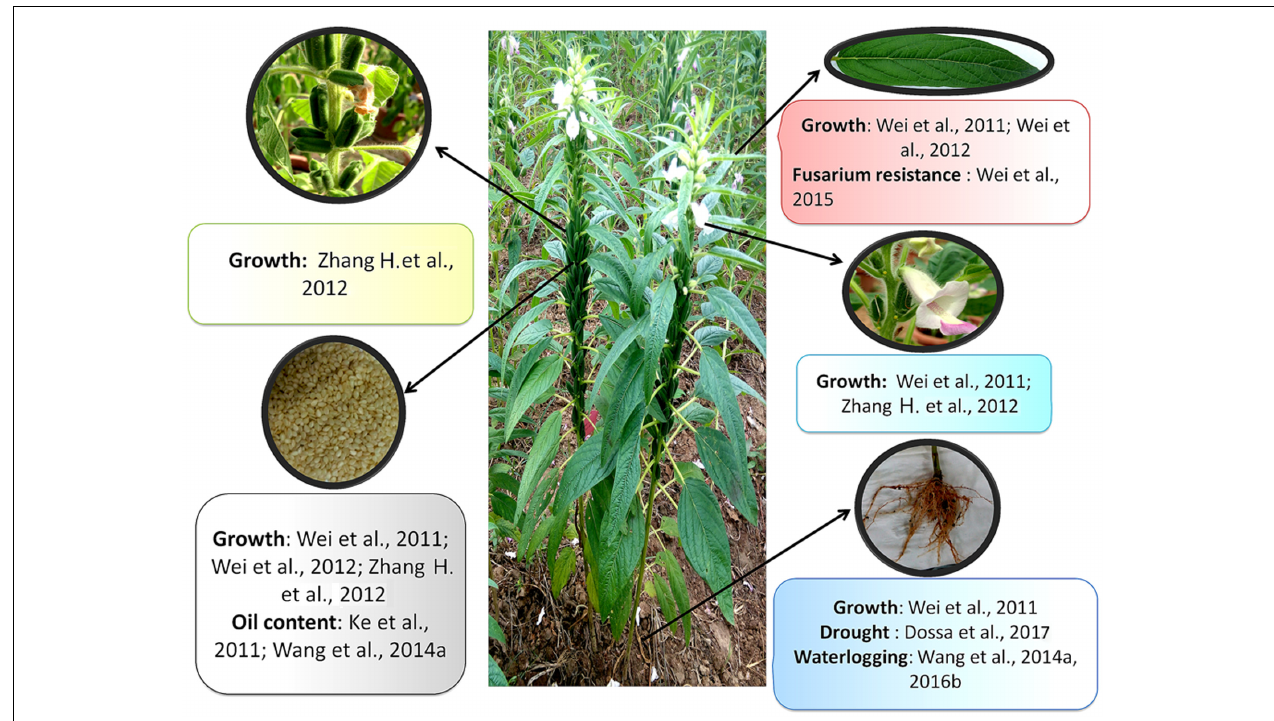
FIGURE 3 | Transcriptome data available and tissues/traits